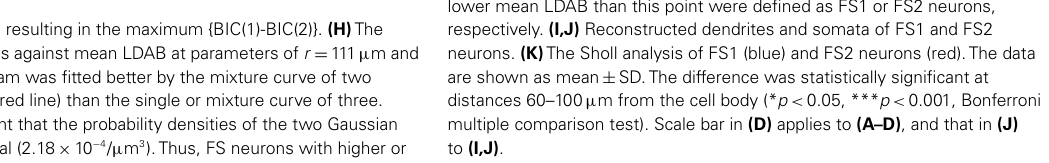
lower mean LDAB than this point were defined as FS1 or FS2 neurons, respectively. (I,J) Reconstructed dendrites and somata of FS1 and FS2 neurons. (K) The Sholl analysis of FS1 (blue) and FS2 neurons (red).The data are shown as mean ± SD.The difference was statistically significant at to (I,J) .